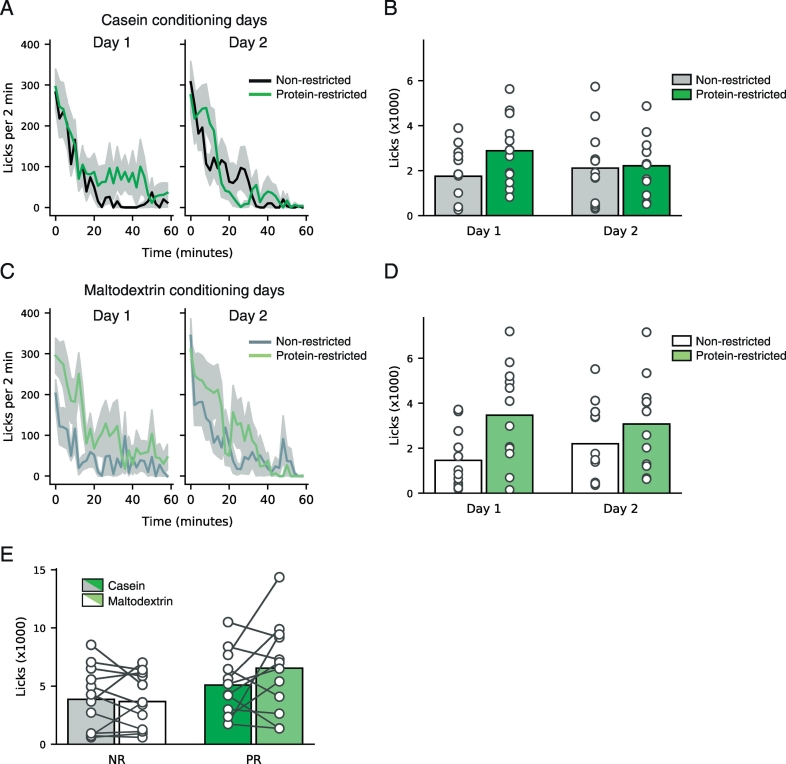
Protein-restricted and non-restricted rats drink similar amounts during conditioning sessions. Rats were given access to distinctly-flavored casein (4%; 2 × 1 h sessions) or maltodextrin (4%; 2 × 1 h sessions) over four days. (A) Time course of licking for casein on conditioning days 1 and 2 during each 1 h conditioning session. Lick rates for non-restricted (black line) and protein-restricted (dark green) rats are shown. Lines are mean and shaded area is SEM. (B) Licks of casein on conditioning days 1 and 2 in non-restricted and protein-restricted rats. (C) Time course of licking for maltodextrin on conditioning days 1 and 2 during each 1 h conditioning session. Lick rates for non-restricted (dark grey) and protein-restricted animals (light green) are shown. Lines are mean and shaded area is SEM. (D) Licks of maltodextrin on conditioning days 1 and 2 in non-restricted and restricted rats. (E) Total licks over both sessions for non-restricted (NR, grey and white bars) and protein-restricted (PR, green bars). Dark bars show casein licks and light/white bars show maltodextrin licks. For all panels, bars represent mean and circles are data from individual rats. [figure = 2 columns]. (For interpretation of the references to colour in this figure legend, the reader is referred to the web version of this article.)